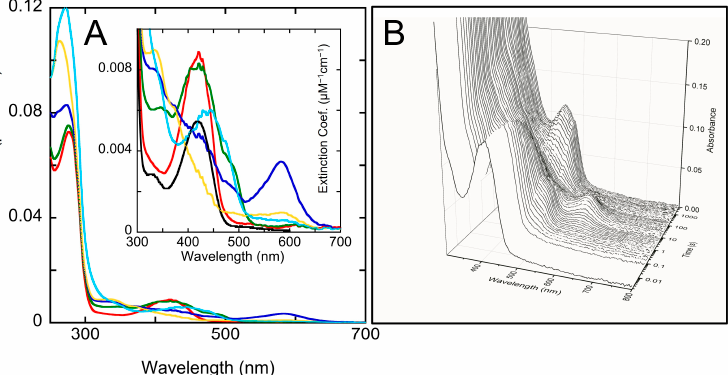
Figure 8. Spectral deconvolution of transient-state CCD data. h OAT (13.4 µM) was allowed to react with 1960 µM of 5 at pH 7.5 at 10 °C (all concentrations indicated are post-mixing). ( A ) Spectra derived from singular value decomposition spectral deconvolution. The spectra arise in the following order, red, green, blue, yellow, cyan. Inset depicts the region of the spectrum from 300– 700 nm. In this plot, the time-zero spectrum of the h OAT internal aldimine is added for reference (black spectrum). ( B ) Three-dimensional depiction of the absorption changes of the h OAT- 5 inhibition reaction. 2.5. The Inactivation Pathway of Compound 5 in hOAT It should be noted that, in general, a quinonoid species (~580 nm) is thought to be formed right after the first external aldimine (~420 nm) (Figure 4, left). However, the transient-state measurement suggests that there is an additional broad aldimine-like species (green spectrum, Figure 8) observed between the quinonoid and the first external aldimine. We thus speculated that External Aldimine I (shown in Scheme 7) may generate an enolate structure as External Aldimine II , which establishes dual interactions with Arg180 based on the molecular docking studies shown in Figure 9A. Free energy calculations in Figure 9B also support the existence of External Aldimine II tautomers, showing comparable results with External Aldimine I . Subsequently, External Aldimine II can undergo further tautomerization, triggered by the lone pair of electrons on Arg180, to form Quinonoid I . The elimination of the fluoride ion gives External Aldimine III , which can undergo attack by Lys292. This transient state further goes through the states of gem -Diamines I and II and releases enamine intermediate Met I . By mass spectrometry analysis, ketone intermediate Met II was detected as the predominant metabolite generated after incubating 5 with h OAT, validating the formation of Met I (Figure S1). The nucleophilic enamine intermediate Met I efficiently attacks the PLP–Lys292 Internal Aldimine and produces Final Product I , thereby inactivating the enzyme, which is covalently bound to PLP. Hydrolysis of the imine of Final Product I gives Final Product II . Elimination of Lys292 leads to Final Product III as the major form, which is in equilibrium with Final Product I (the minor form).